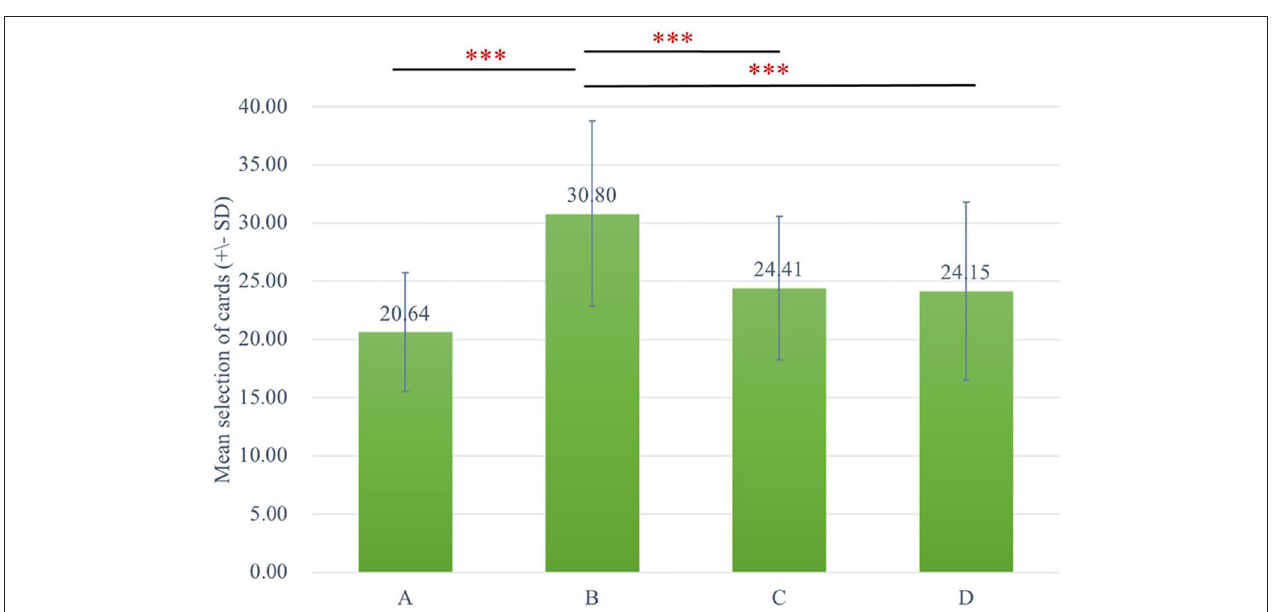
Frontiers in Psychology |